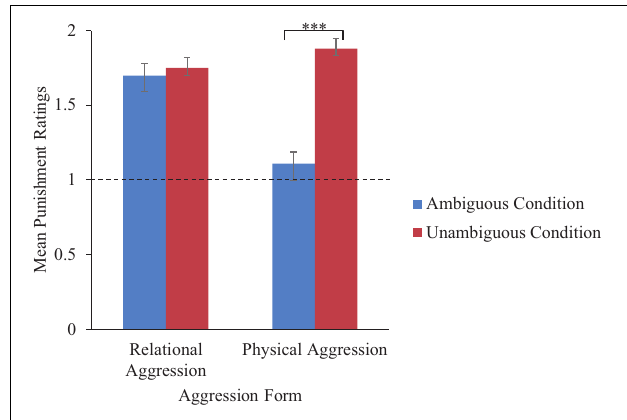
FIGURE 4 | Mean punishment ratings by aggression form and ambiguity condition across age groups. Error bars represent SEs. Note that acceptability ratings were coded as follows: 0, no; 1, yes. Ratings were summed across transgressor gender, resulting in a range of 0–2. *** Indicates a significant difference ( p < 0.001) between the ambiguous and unambiguous